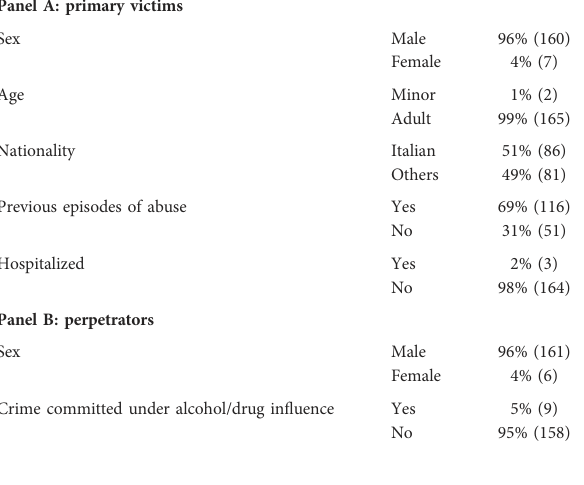
TABLE 1 Primary victims (Panel A) and perpetrators (Panel B) main characteristics.